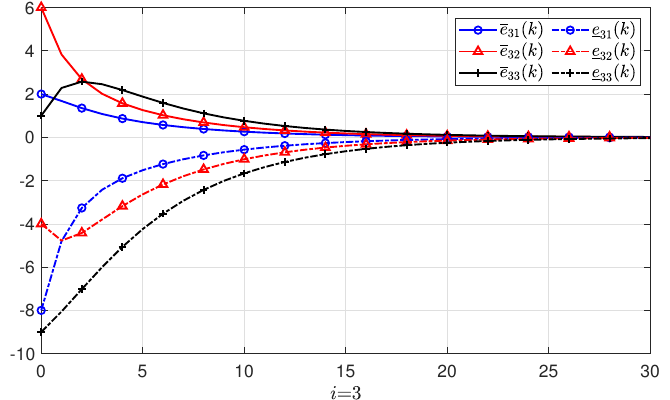
Figure 8. The simulations of state estimate errors e 3 ( k ) of the 3th